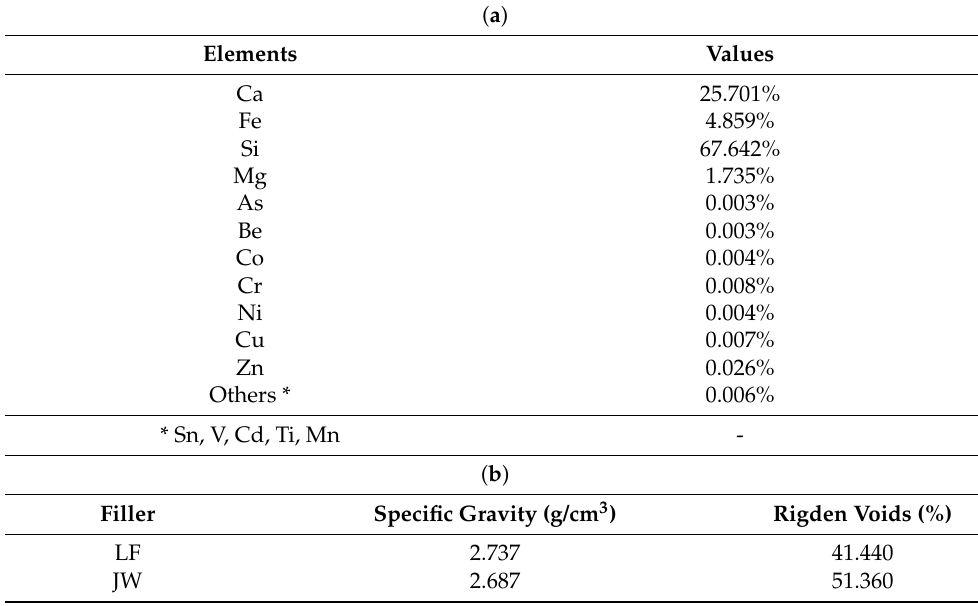
Table 2. Chemical properties of jet grouting waste.